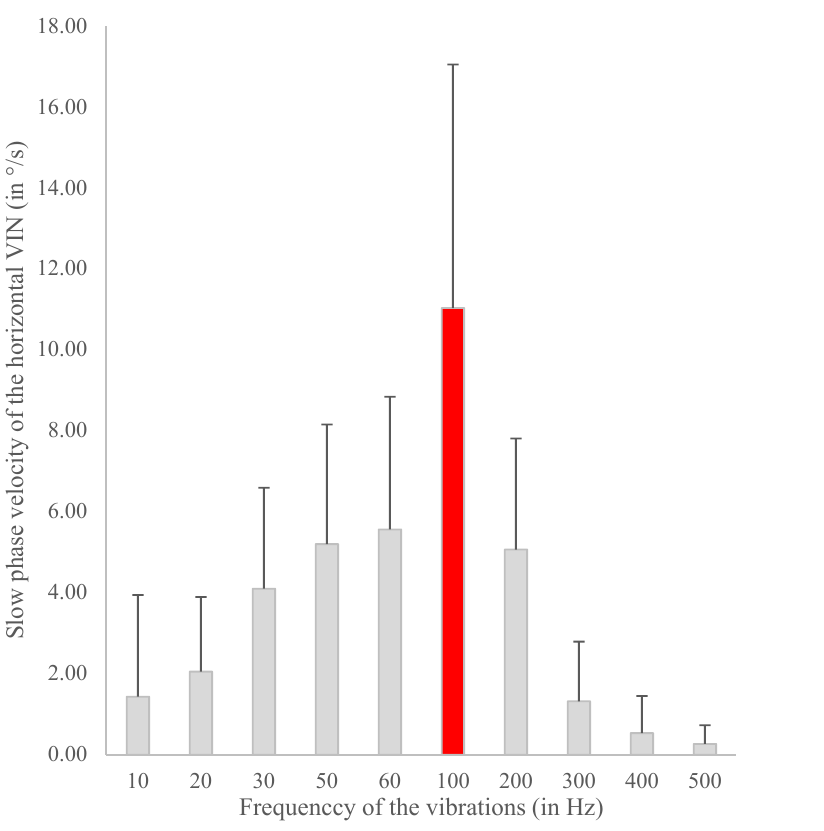
Figure 2. Frequency optimization (SVIN horizontal component) in 15 Total Unilateral Vestibular Loss patients (Translabyrinthine approach or Vestibular neurectomy). Stimulation with the Minishaker (Bruel Kjaer (B&K), Naerum, the Netherlands). Presented by Dumas et al. at the American Academy of Otolaryngology–Head and Neck Surgery (AAO-HNS) Congress, New Orleans, LA, USA, 2019